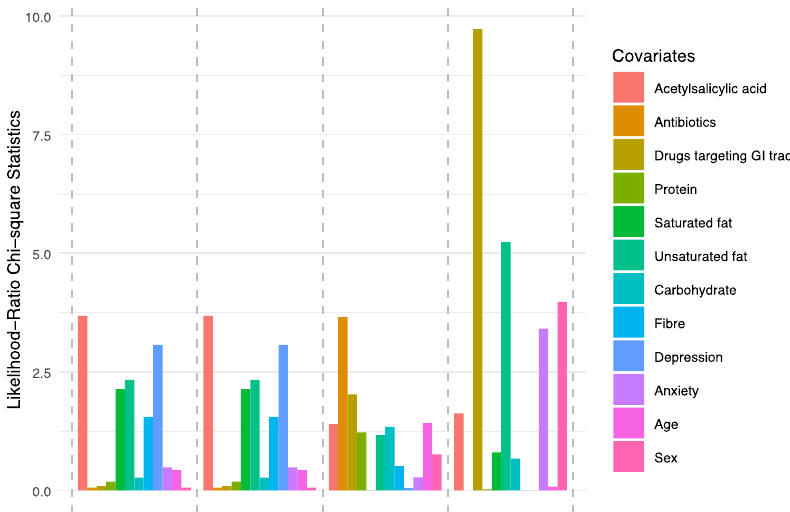
Figure 6. Assessment of relative importance of all covariates. A complete model comprising all covariates for assessing variable importance. The relative importance of each covariate was measured as likelihood-ratio chi-square statistics.